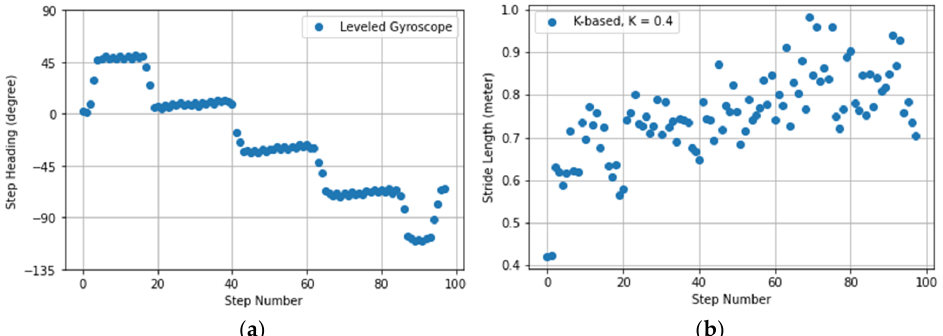
Figure 2. Realization of pedestrian dead reckoning (PDR) elements in the reproduction of available benchmarks: ( a ) step heading calculation from leveled gyroscope values; ( b ) K-based stride length estimation.